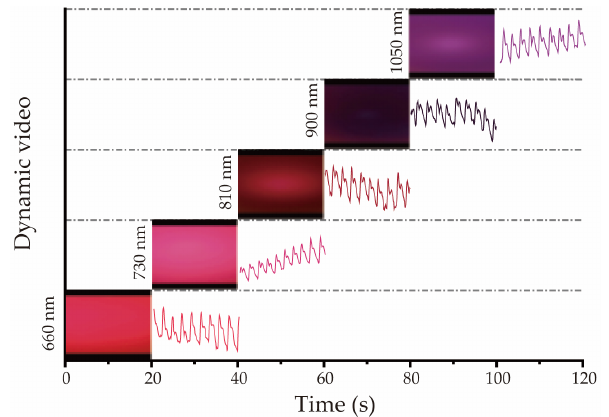
Figure 3. Schematic of the PPG data measurement and the waveforms display in sequence.